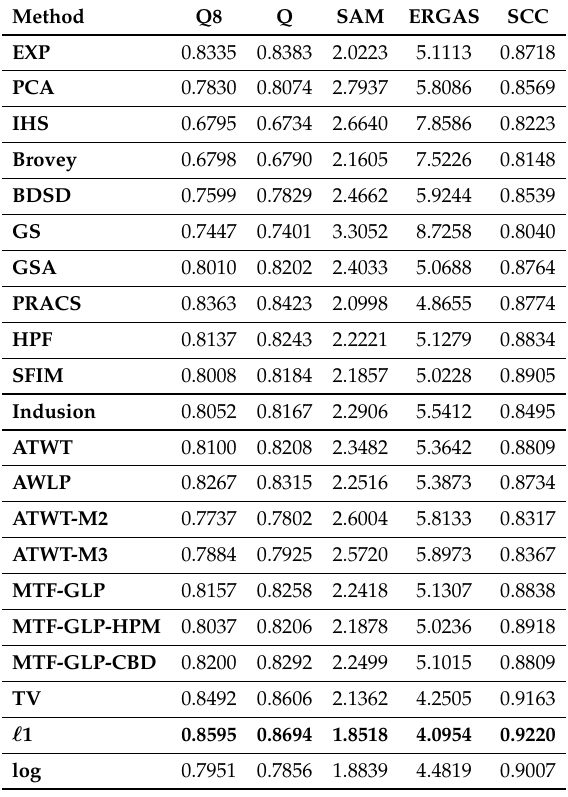
Table 3. Quantitative results on the LANDSAT 7-ETM+ Chesapeake Bay image. Bold values indicate the best score.